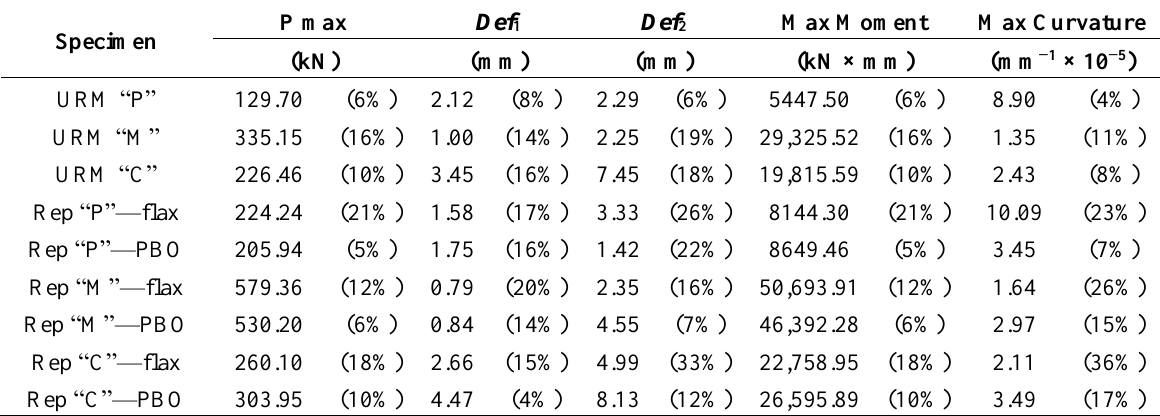
Note: The coefficients of variation (CoV%) are reported in brackets. Table 4. Increase in load capacity and ultimate composite strains.